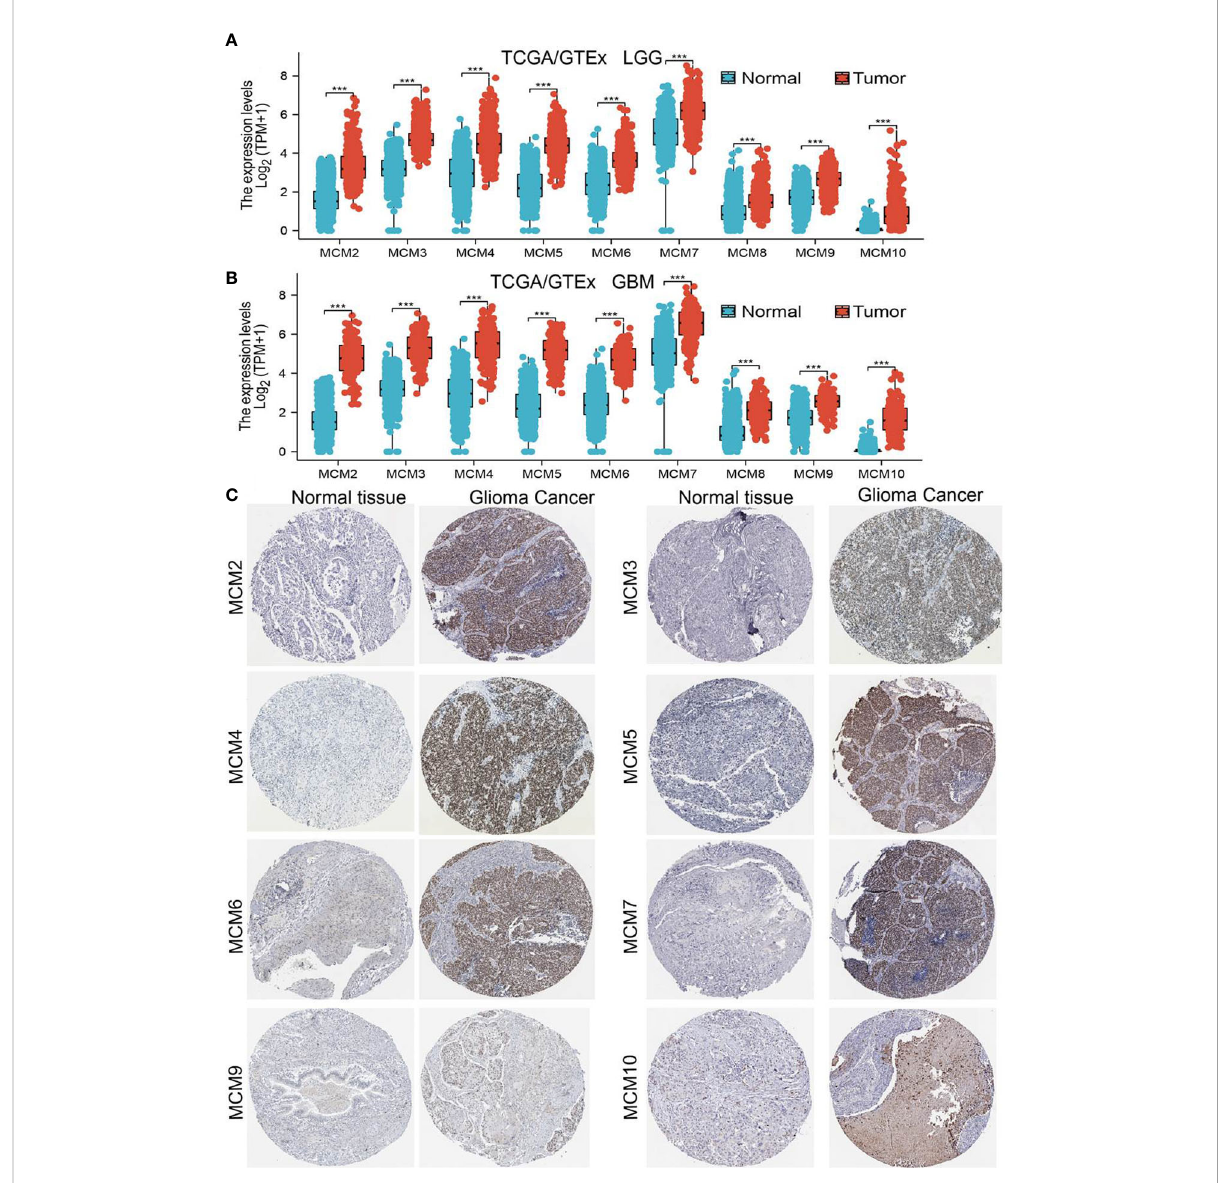
FIGURE 1 MCMs are highly expressed in glioma. (A, B) The expression of MCMs in normal brain tissues and LGG/GBM was examined by TCGA/GTEx databases. (C) The protein expression of MCMs in glioma tissue was examined by the HPA database. ***p <